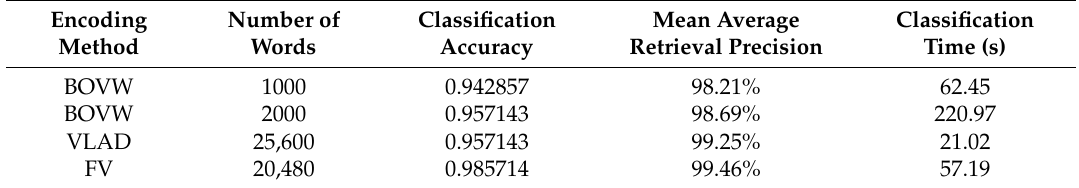
Table 1. The results of the three kinds of classification algorithms.